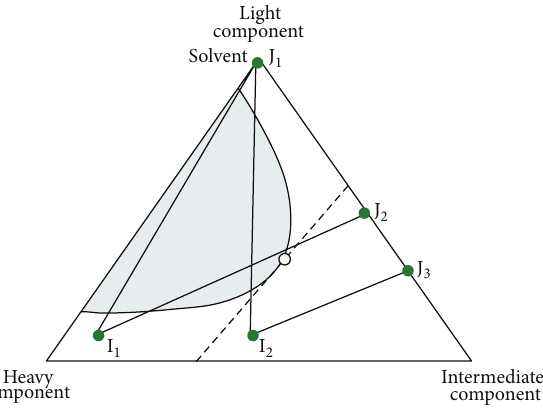
Figure 1: Phase ternary diagram for reservoir oil and injection gas relation [5].